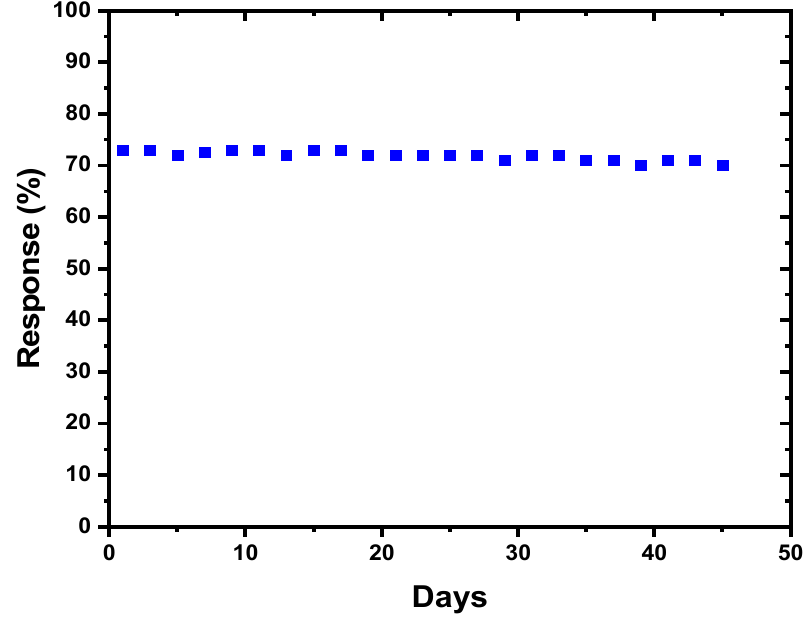
Figure 9. Long-term stability of the Ag NPs/V 2 O 5 thin film/Au NPs exposed to 20 ppm acetone at 150 °C.